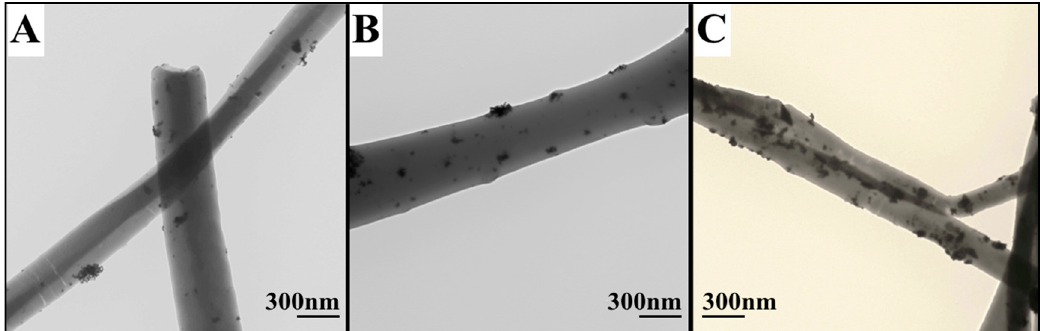
Figure 8. TEM micrographs of catalytic particles embedded on to ( A ) as-spun, ( B ) heat-treated, and ( C ) polarized PVDF fibers.